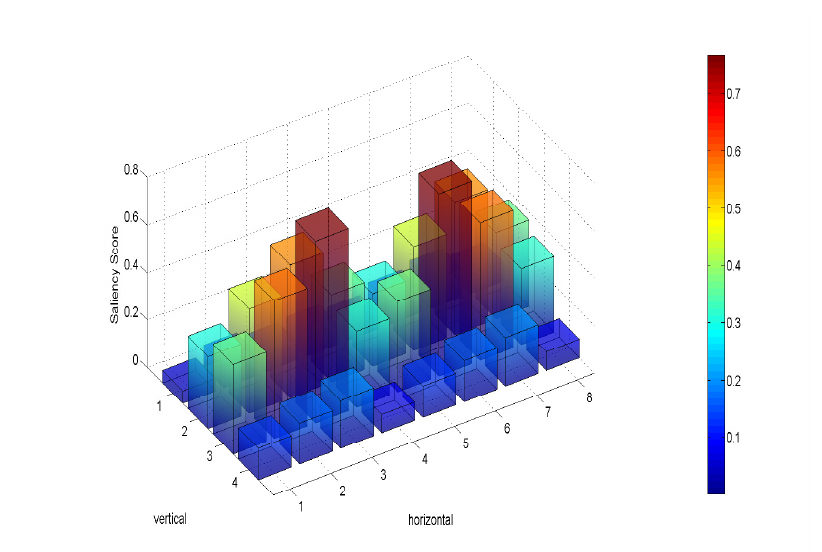
Figure 3. Saliency score of an ERP VR video frame with 4 × 8